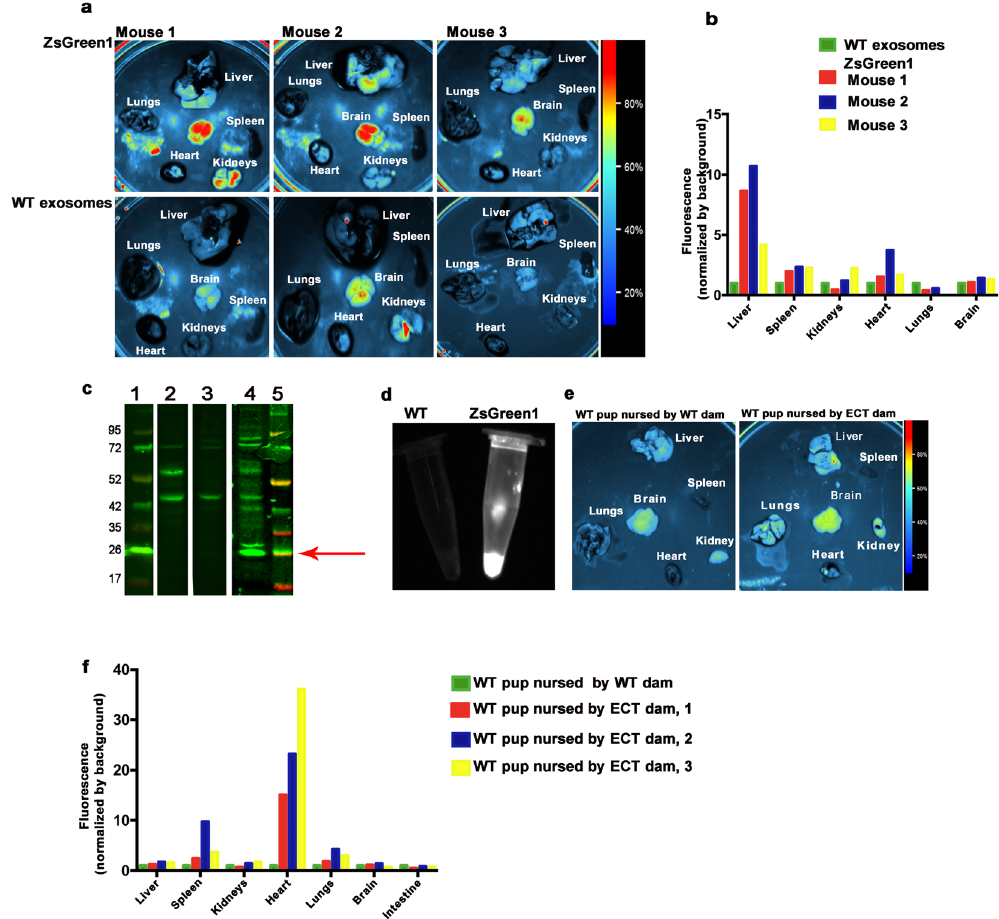
Figure 2. Absorption and distribution of murine and porcine milk exosomes endogenously labeled with fluorescent proteins in mice and pigs. ( a ) Fluorescence signal of porcine ZsGreen1 milk exosomes (upper panel) and WT exosomes (lower panel; 1 × 10 12 /g body weight) in murine tissues excised 3 hours after intravenous injection. ( b ) Densitometry analysis of fluorescence in tissues excised from mice injected with porcine ZsGreen1 or WT milk exosomes. ( c ) Western blot analysis of ZsGreen1 in protein extracts from WT piglets nursed by a transgenic ZsGreen1 sow for 17 days. Lanes: 1, Marker; 2, cerebellum in WT pig; 3, cerebellum in a stillborn (not nursed) WT pig; 4, cerebellum in WT pig nursed by a transgenic sow; and 5, marker. ( d ) Porcine milk exosomes purified from WT (left) and transgenic ZsGreen1 pigs (right). ( e ) CD63/eGFP-labeled exosomes in WT mouse pups nursed by an ECT transgenic dam for 17 days. ( f ) Densitometry analysis of fluorescence in tissues excised from WT pups nursed by an ECT transgenic dam for 17 days compared with tissues excised from WT pups nursed by WT dam for 17 days. Panels in this figure were assembled from multiple independent images and gels; individual images in the grouped figure are separated by white